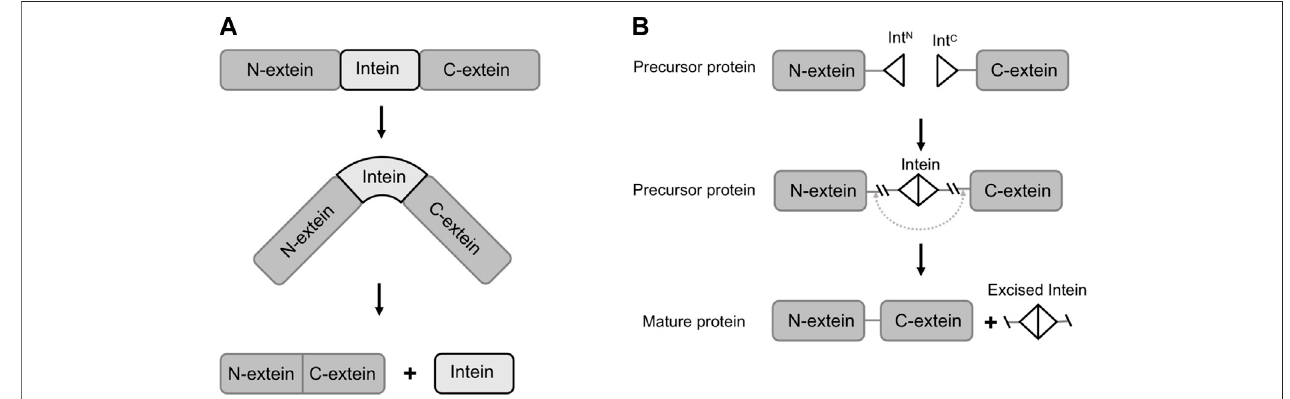
FIGURE1 | Schematic of protein splicingof inteins ( trans -splicing and cis -splicing). (A) The translation of theprecursorprotein and its splicing in cis . (B) Split intein mediated protein splicing in trans . Int N , split N-intein; Int C , split C-intein.